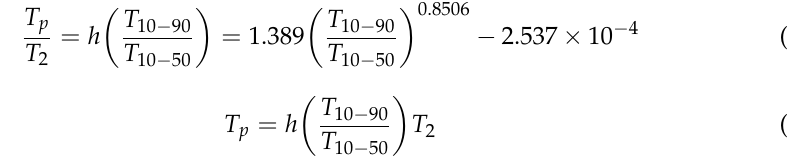
the standard [10]. The standard formula is accurate in cases of the waveform with time to crest close to the standard time to peak (250 μ s). The shorter the T p is, the higher the devi- ation is. Additionally, as shown in Figure 7 the proposed approach for the T 2 determina- tion also provides promising accuracy when it is compared with the previously developed formula [1]. The maximum deviations of the proposed and previously developed formu- maximum deviations of the proposed and previously developed formulas are 0.165% and las are 0.165% and 0.98%, respectively. 0.98%, respectively. las are 0.165% and 0.98%, respectively.